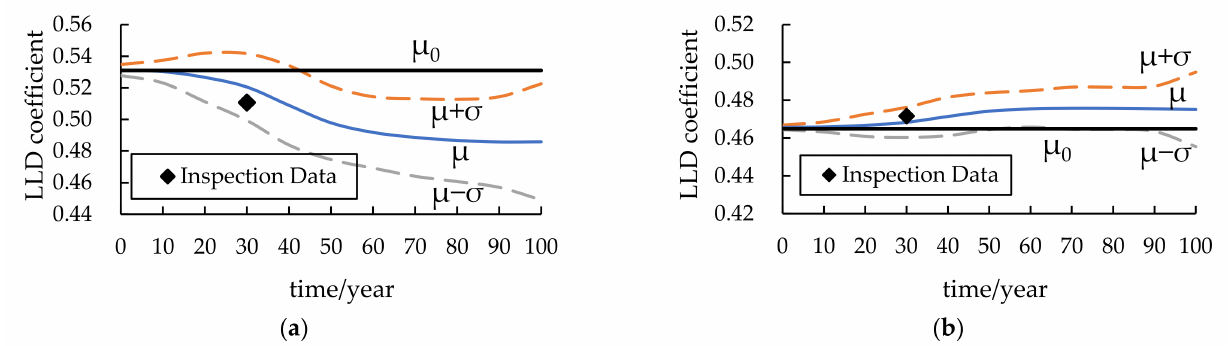
Figure 5. Vehicle load arrangement: ( a ) load vehicle layout along the bridge and measuring point layout; ( b ) transverse arrangement of load vehicle; ( c ) field test.